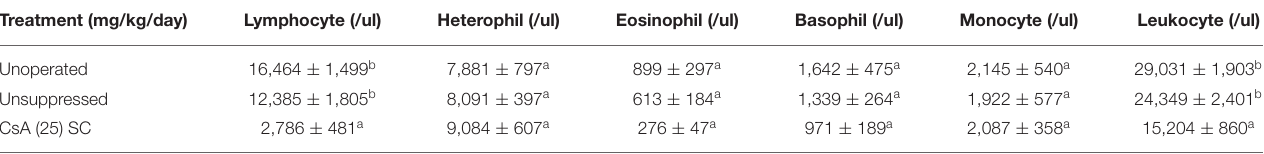
TABLE 6 | Concentration of circulating leukocytes and their subsets, from Study 3.